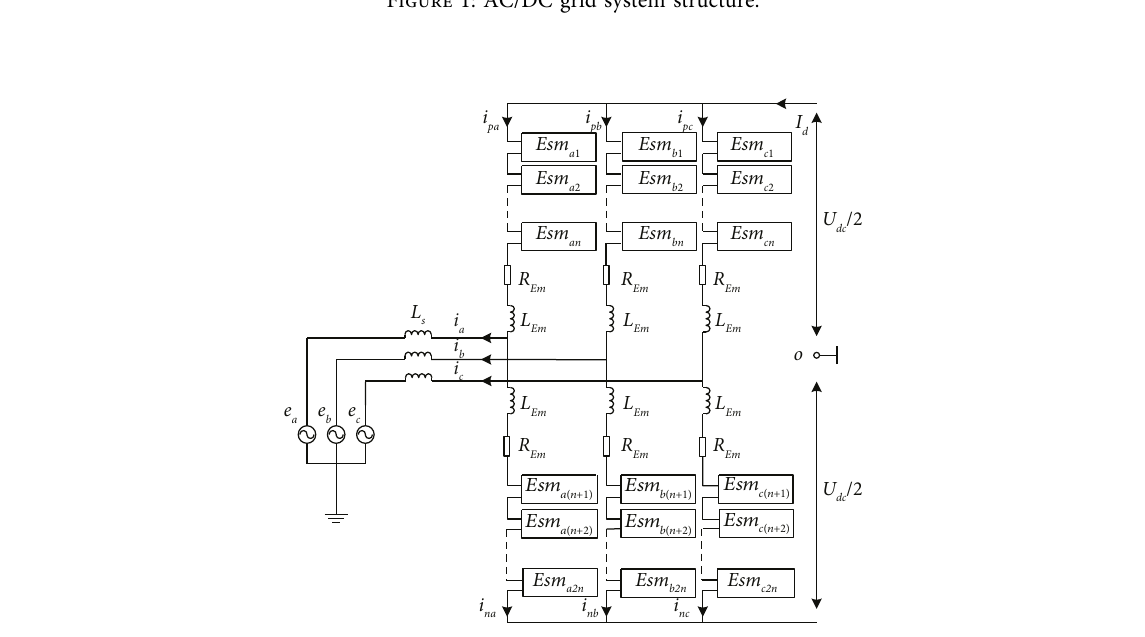
Figure 1: AC/DC grid system structure.